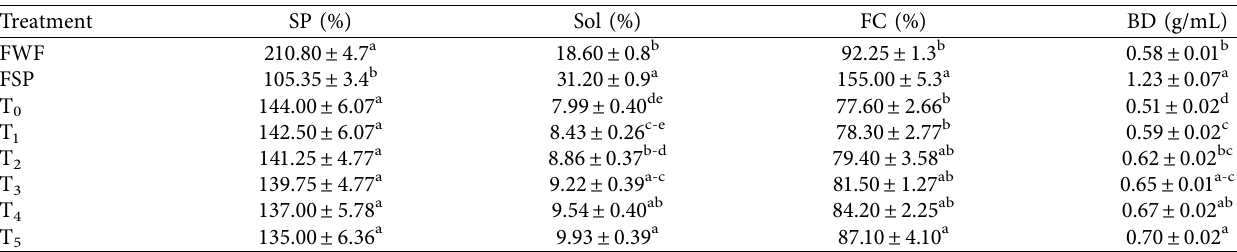
Values are presented as means ± SD ( n � 3). Values having similar lettering in each column show non-significance at p > 0 . 05. T 0 � 100% fine wheat flour (FWF) based noodles (control), T